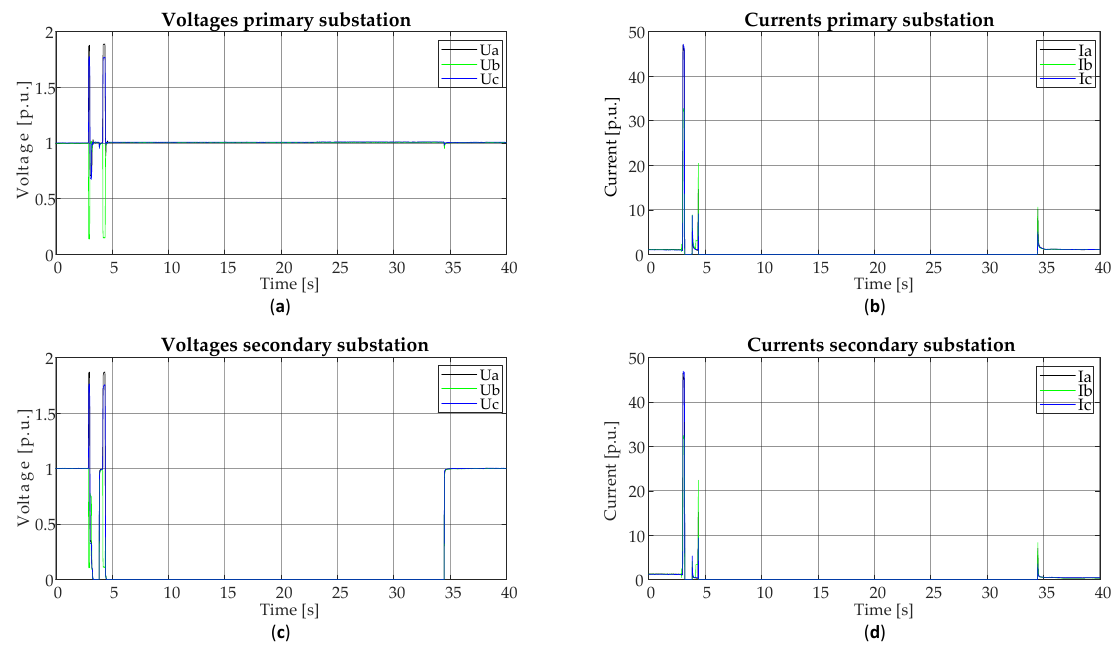
Figure 6. A full resolution of the phasor measurement unit (PMU) measurements for an event that triggered the event detector in a real-life environment: ( a ) Voltage measurements of the primary substation’s PMU; ( b ) Current measurements of the primary substation’s PMU; ( c ) Voltage measurements of the secondary substation’s PMU; ( d ) Current measurements of the secondary substation’s PMU.